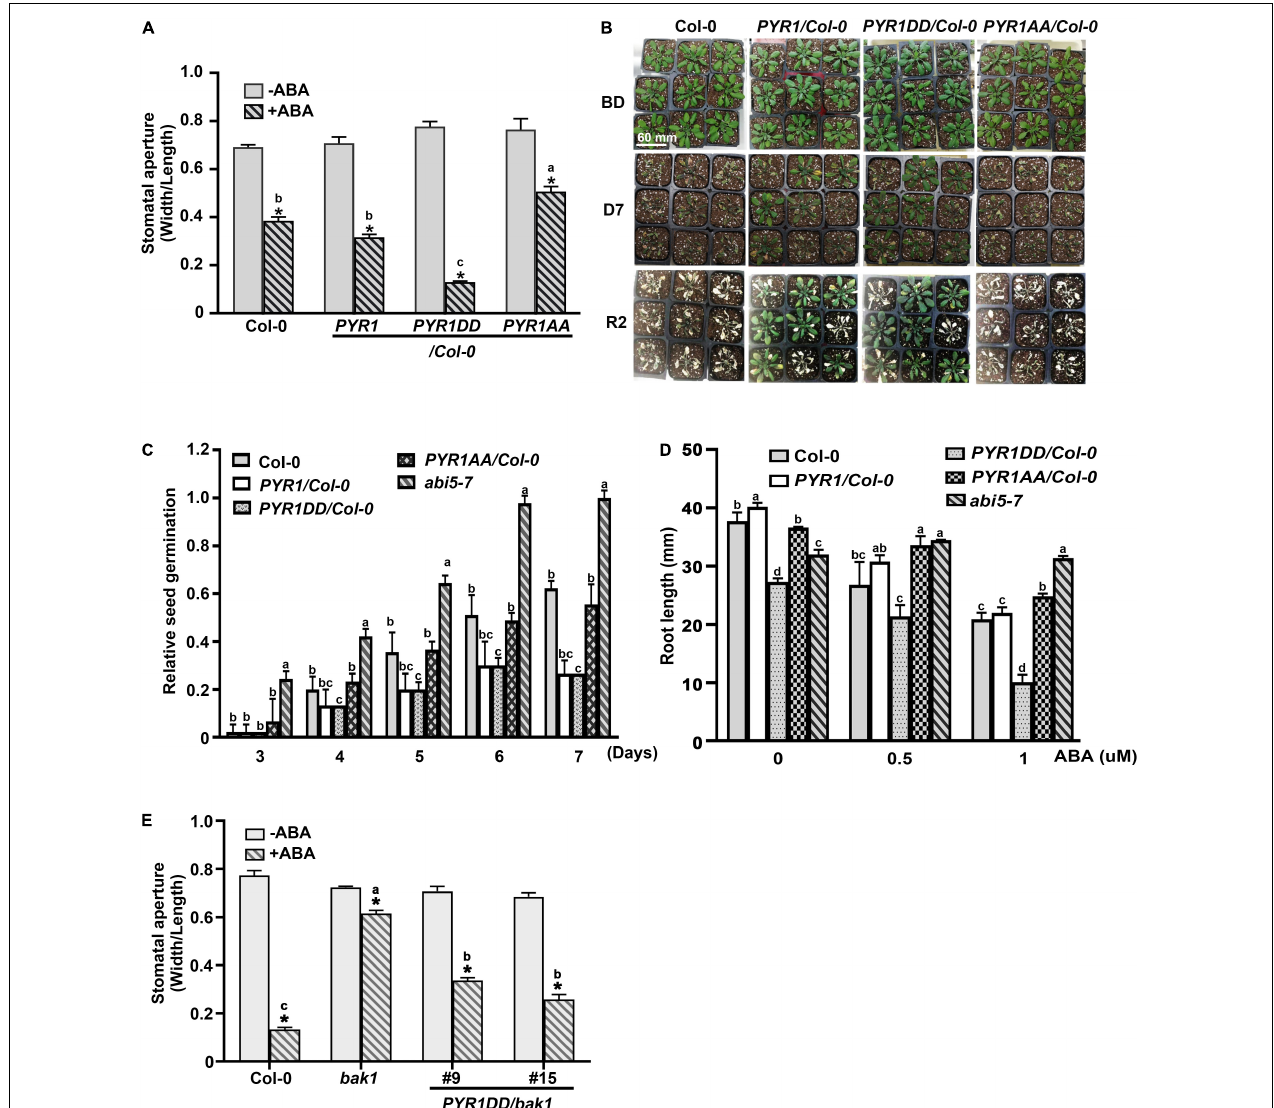
FIGURE 4 | PYR1DD and PYR1AA variants increase ABA responses in plant. (A) BAK1 phosphorylation of PYR1 results in ABA hypersensitivity in stomatal closure. ABA-induced stomatal closure was measured in transgenic plants expressing PYR1DD and PYR1AA , compared with transgenic plants expressing PYR1 and wild-type plants (Col-0) treated with or without 1 µ M ABA for 2 h. Stomatal apertures were recorded using the width/length ratio of cotyledon stomata. Experiments were independently repeated thrice ( n = 20 for each replicate). * P < 0.0001 compared with the corresponding samples without ABA treatment. Data from stomatal apertures in the presence of ABA were also analyzed using one-way ANOVA and Tukey’s multiple comparisons test; P < 0.05. Different letters indicate statistically significant data. (B) PYR1 phosphorylation of BAK1 induced plant resistance to drought. PYR1 - or PYR1DD -expressing transgenic plants showed greater drought resistance than wild-type (Col-0) and PYR1AA -expressing plants. Each plant line was grown for 4 weeks under normal conditions. And then, irrigation was withdrawn for 7 days and was then resumed. BD: before drought; D7: drought for 7 days; R2: resumed growth 2 days after re-watering. Scale bar indicates 60 mm (pot size). (C) BAK1 phosphorylation of PYR1 increases sensitivity to ABA during inhibition of seed germination. Seed germination of the transgenic plants overexpressing wild-type PYR1 , PYR1DD, and PYR1AA was compared with wild-type plants treated with 5 µ M of ABA. The known ABA insensitive mutant, abi5-7 , was included as a negative control. Germination ratios were calculated for each indicated day. Experiments were repeated thrice. At each time point, 50 seeds per plant line were observed each day. (D) BAK1 phosphorylation of PYR1 increases ABA sensitivity of inhibition of root elongation. ABA-induced root growth inhibition of PYR1DD and PYR1AA transgenic plants was compared with PYR1 , abi5-7, and wild-type plants. Root lengths of 8-day-old seedlings grown on 1/2 MS media containing the indicated concentrations of ABA were measured. Experiments were repeated thrice ( n = 20 seedlings per replicate). Data for (D,E) were analyzed using one-way ANOVA and Tukey’s multiple comparisons test; P < 0.05. Different letters indicate statistically significant data under the indicated germination time (in C ) or concentration of ABA treatment (in D ). (E) Overexpression of PYR1DD partially rescued an insensitivity of bak1 in ABA-induced stomatal closure. ABA-induced stomatal closure was measured in transgenic bak1 mutant expressing PYR1DD compared with wild-type (Col-0) plants and bak1 mutants treated with or without 1 µ M ABA for 2 h. * P < 0.0001 compared to the corresponding samples without ABA treatment. Data of stomatal apertures in the presence of ABA were also analyzed using one-way ANOVA and Tukey’s multiple comparisons test; P < 0.05. Different letters indicate statistically significant data.